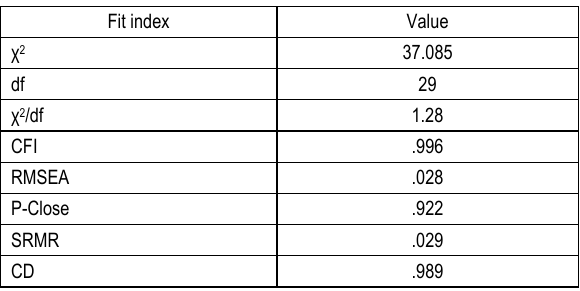
Table 2. Goodness of fit indices of the measurement Table 3. Validity and reliability of measurement